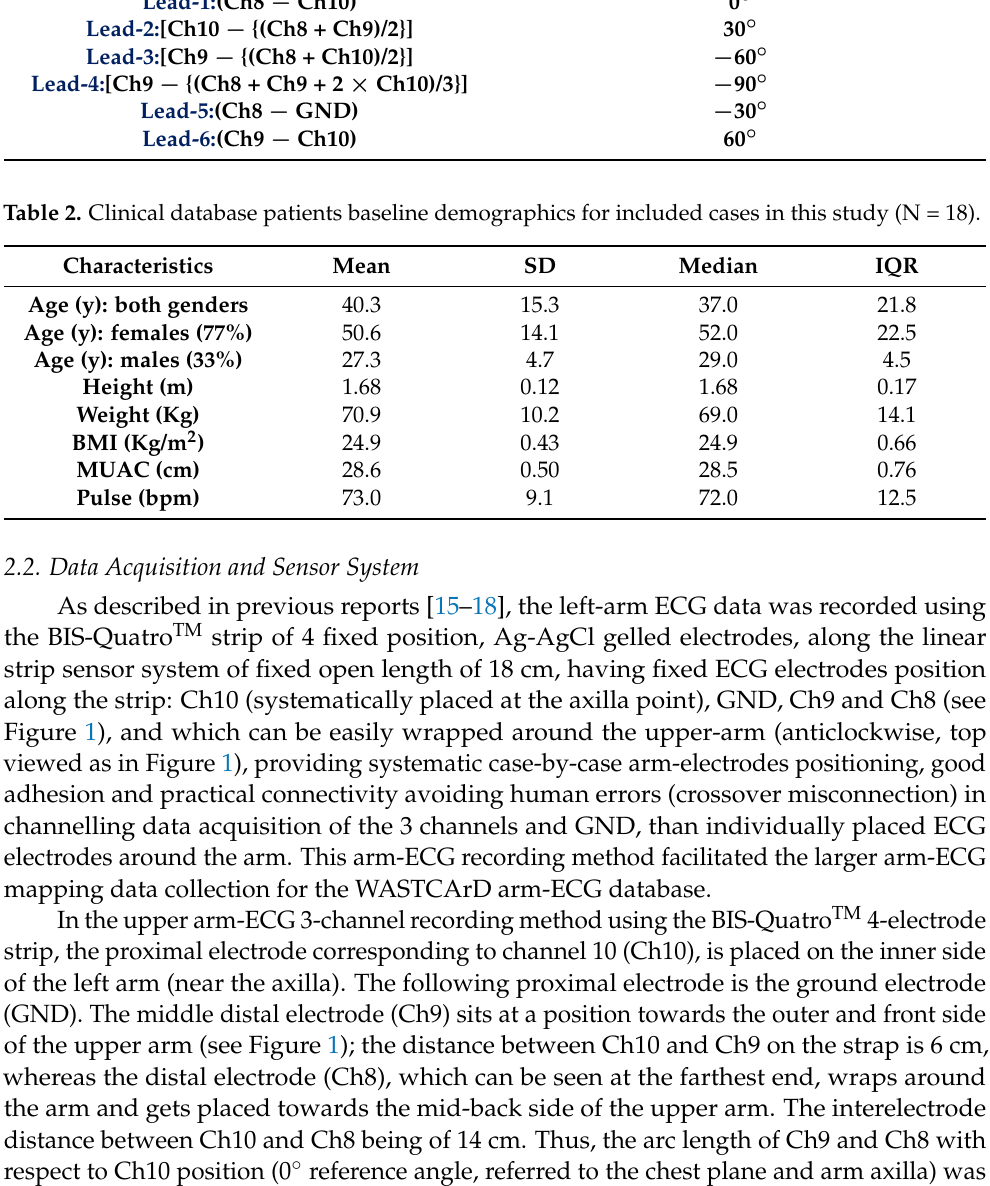
Table 1. Bipolar Arm-Leads their definition and their reference axis rotation angles. Bipolar Arm-Lead Definition